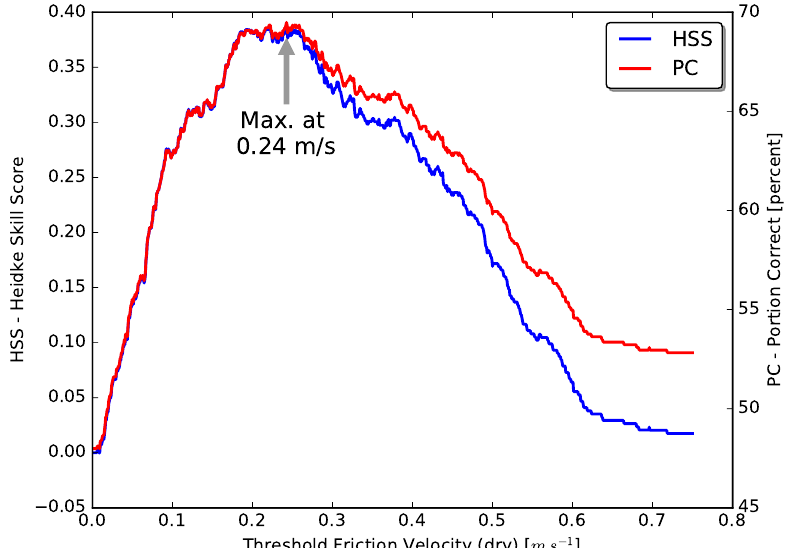
Figure 10. Percentage of correct predictions ( PC ) and Heidke skill score ( HSS ) for different values of the parameter u ∗ t ( dry ) . The maximum skill is obtained for the optimal value u ∗ t ( dry ) = 0.24ms − 1 , corresponding to scores of almost PC = 70% and HSS =